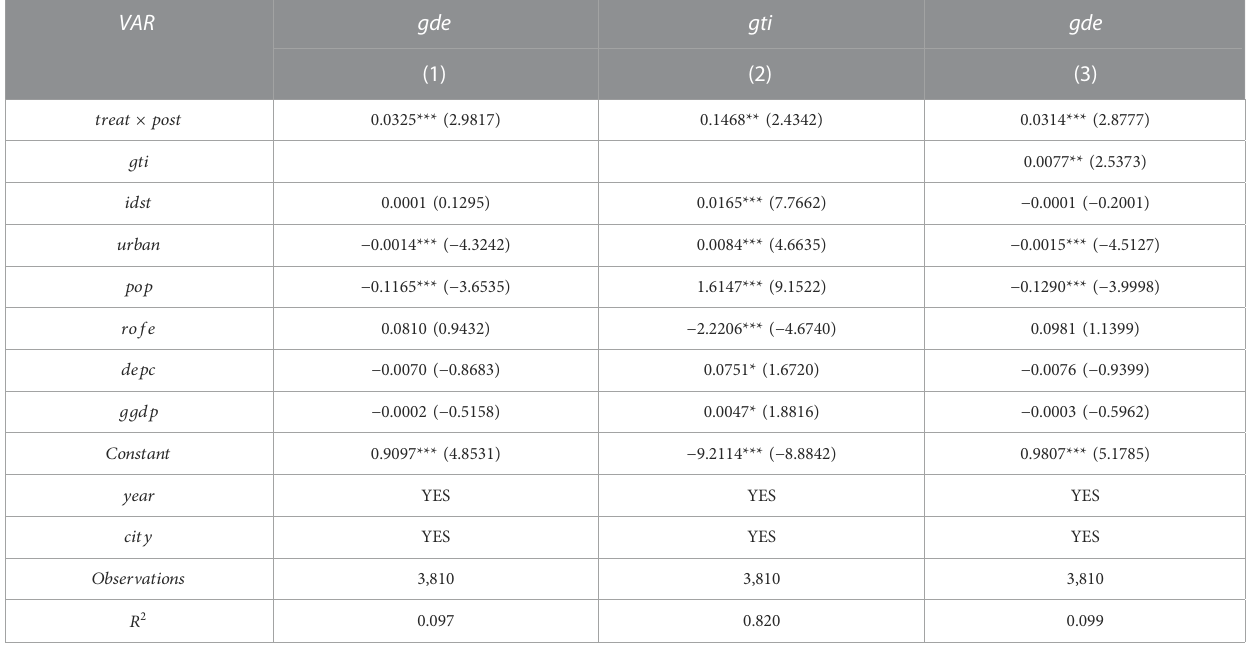
TABLE 4 Mechanism test.